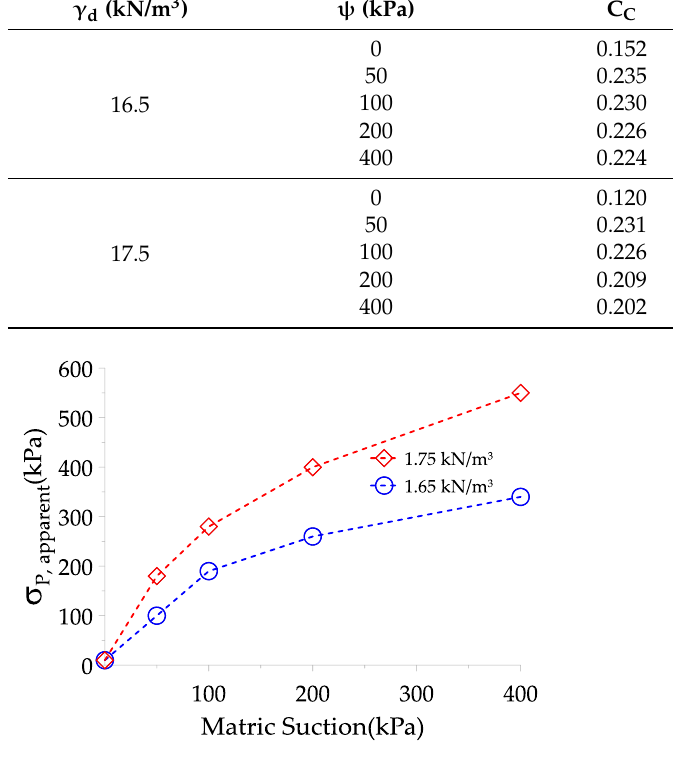
Figure 12. Effect of matric suction on the apparent pre-consolidation